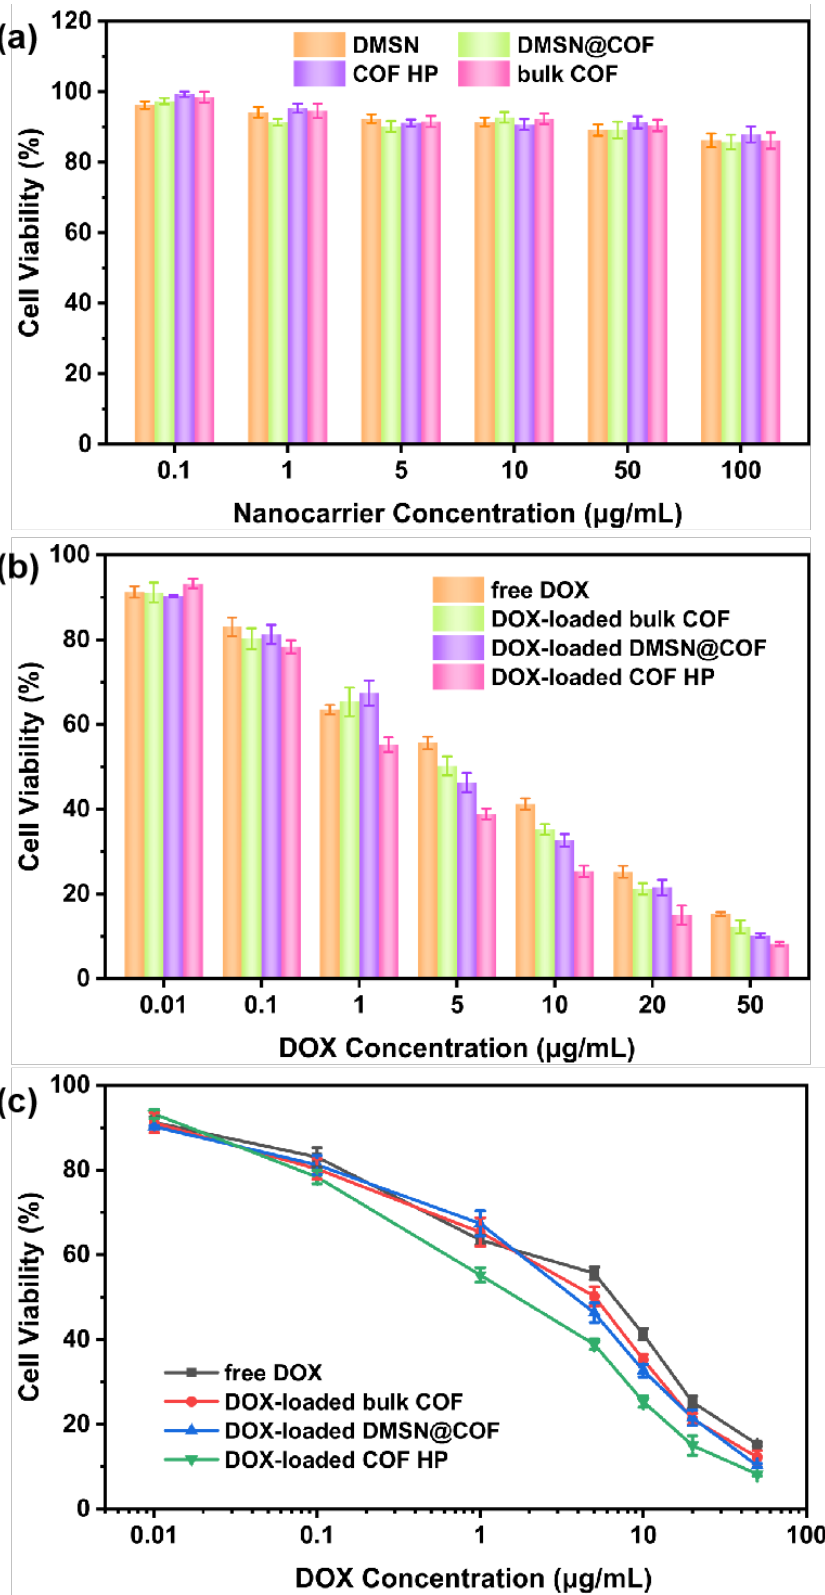
Figure 7. The biocompatibility of DMSN, bulk COF, DMSN@COF, and COF HP to the L929 cells ( a ). Cytotoxicity of the free DOX, DOX-loaded bulk COF, DMSN@COF, and COF HP to the A549 cells ( b , c ).